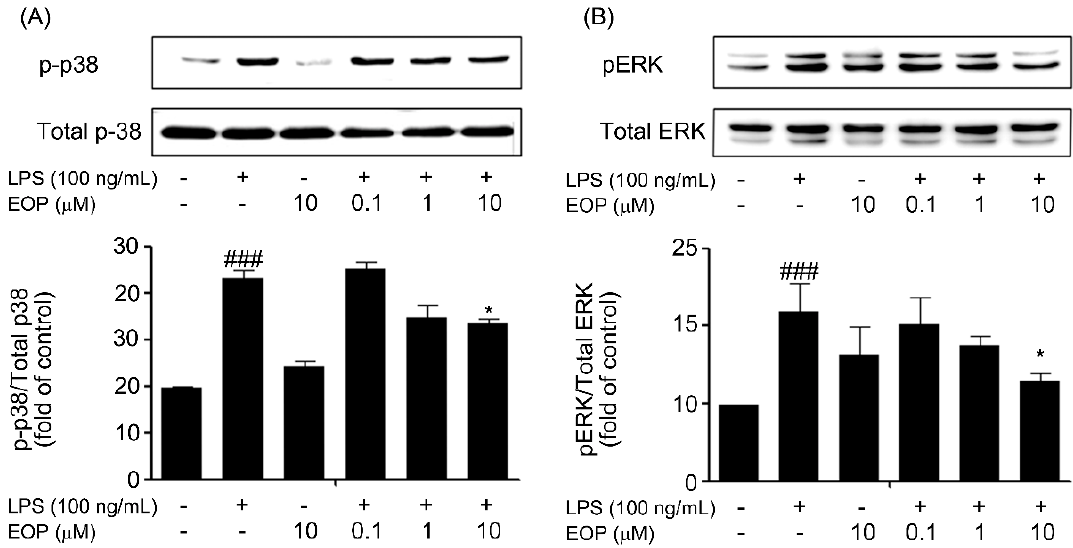
Figure 5. EOP suppresses lipopolysaccharide (LPS)-stimulated p38 and extracellular regulated kinase (ERK) phosphorylation by EOP in BV-2 microglial cells. BV-2 microglial cell lysates were obtained 30 min post-activation with LPS (100 ng/mL) in the absence or presence of EOP (0.1, 1 and 10 μ M). ( A ) Levels of phospho-p38 and ( B ) ERK are expressed as a relative change in comparison to the LPS treatment. Densitometric analysis of the p38 and ERK-mitogen activated protein kinase (MAPK) band are shown in the lower panel. Data are the mean ± standard error of three independent experiments. ### p < 0.001 compared with the control group; * p < 0.05 compared with the LPS-treated group. Significance was determined by one-way analysis of variance followed by Bonferroni’s multiple comparison